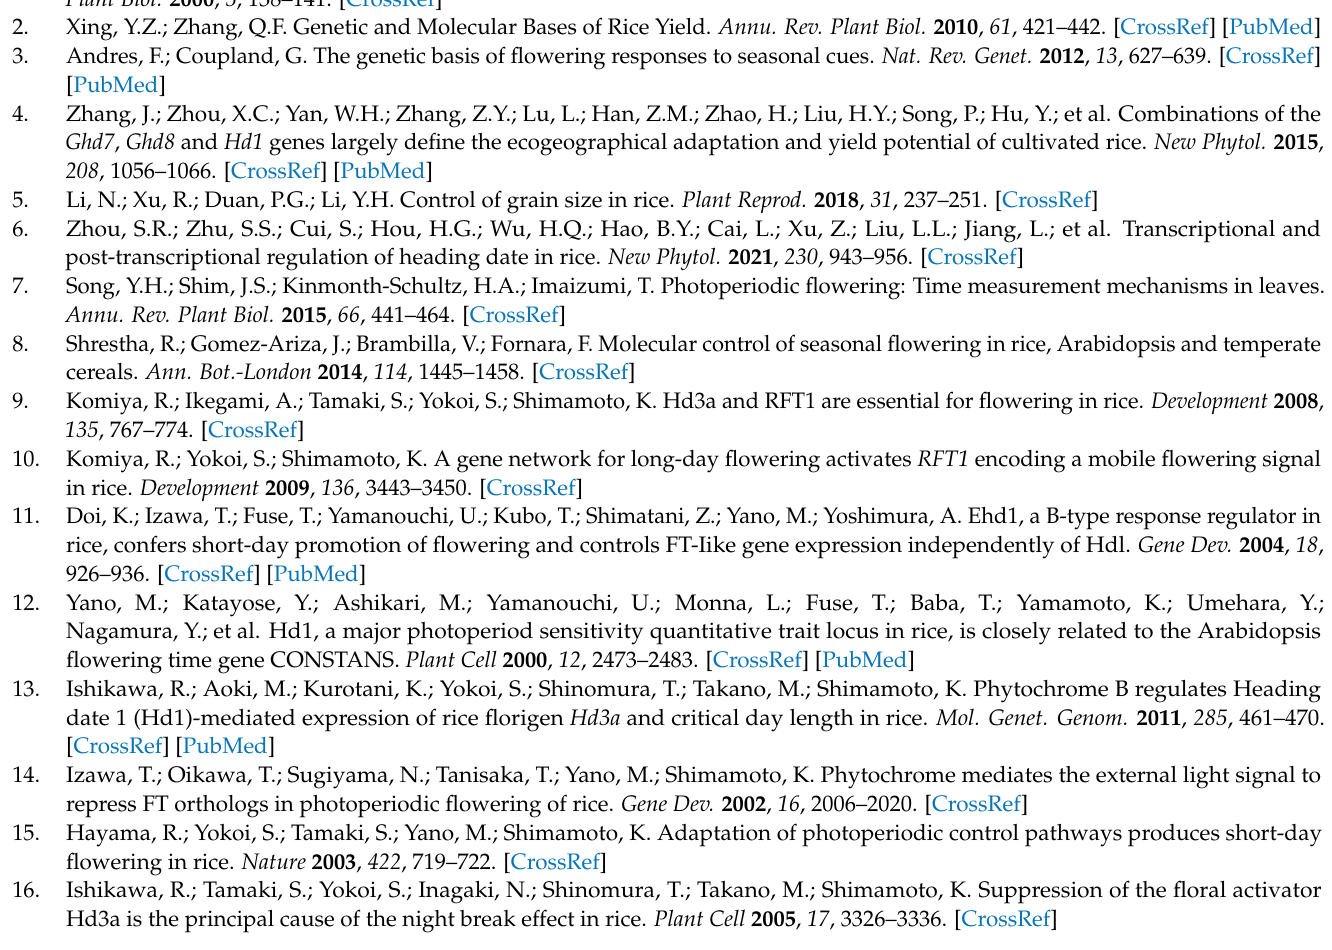
tal Figure S5. RT-PCR analyses of the expression of the OsMOS1 genes in wild-type Arabidopsis (ecotype Col-0) and OE: OsMOS1 / atmos1-6 (lines 1, 2, 3, 4, and 5)